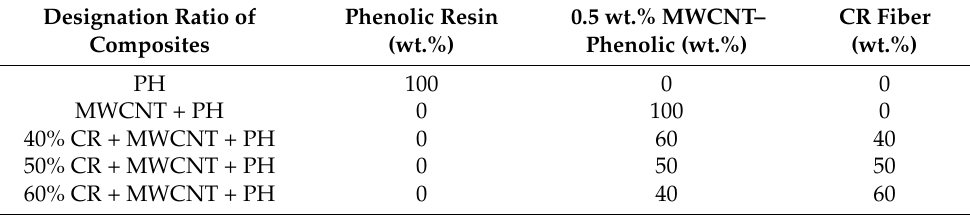
Figure 1. Schematic diagram of the fabrication of CR fiber-reinforcement MWCNT-Phenolic composites by dry dispersion method. Table 1. Composites formulation.